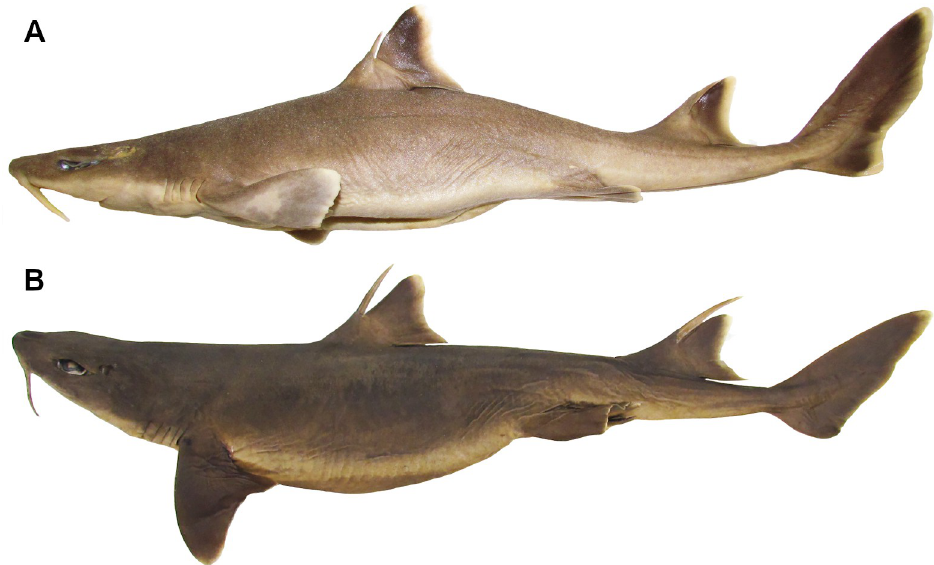
Fig 27. Cirrhigaleus australis in lateral view. A: CSIRO H 7042–04, juvenile female, 605 mm TL, Australia; B: NMNZ P 34821, adult male, 971 mm TL, New Zealand. elongate, its length 4.4%–6.2% TL, usually reaching the mouth ( vs . nasal barbel non mous- tache-like and conspicuously short, its length 1.0%–1.5% TL, never reaching the mouth in C . asper ), and dermal denticles bat-like with narrow median ridge ( vs . heart-shaped with broad median ridge in C . asper ). It further differs from C . asper by smaller length of upper labial fur- row, its length 0.9%–1.4% TL ( vs . 1.4%–2.1% TL). Cirrhigaleus australis is separated from C . barbifer by having teeth with narrow apron ( vs . broad in C . barbifer ), and dermal denticles with one cusplet lateral-posteriorly on each side ( vs . two cusplets in C . barbifer ) (Fig 27). Description . Morphometric and meristic data are shown in Table 3 and S3 and S4 Tables. External morphology . Body trihedral, strongly robust and humped in all its extension, con- spicuously arched from posterior margin of the eye to pelvic fin insertion with belly noticeable ventrally (more slender when juveniles than in adults); body equally wide from head to abdo- men with head width 1.0 (0.9–1.2) times trunk width, and 1.0 (1.0–2.1) times abdomen width; body deepest at trunk and abdomen with head height 0.7 (0.6–1.5) times trunk height, and 0.7 (0.7–1.5) times abdomen height. Head very small, its length 20.0% (18.2%–23.1%) TL, flat- tened and narrow anteriorly, humped and broader posteriorly near the mouth; head width at nostrils 7.1% (6.4%–7.7%) TL, and at mouth 11.8% (10.4%–13.6%) TL. Eyes oval and elongate, its length 3.3% (3.1%–4.6%) TL and corresponding to 2.1 (2.1–5.5) times its height; anterior margin of eye convex, posterior margin slightly notched, prominent dorsally. Spiracles cres- cent and wide, its length 0.8 (0.8–1.8) times eyes height, placed lateral-posteriorly and above the eyes. Gill slits vertical and slightly concave, tall with height of fifth gill slit 2.3% (1.9%– 2.7%) TL, corresponding to 1.3 (0.9–1.4) times first gill slit height. Snout very short, preorbital length 6.5% (5.8%–7.2%) TL and conspicuously rounded at the tip; nostrils equally near to snout tip and upper labial furrow, its prenarial length 0.9 (0.9–1.4) times distance from nostrils to upper labial furrow; anterior nasal flap bilobate with second lobe markedly elongate and moustache-like as nasal barbels, reaching anterior margin of mouth in adults (young speci- mens have nasal barbels markedly beyond posterior margin of the mouth); anterior nasal flap length 5.0% (4.4%–7.1%) TL, corresponding to 4.0 (2.6–5.1) times in head length.